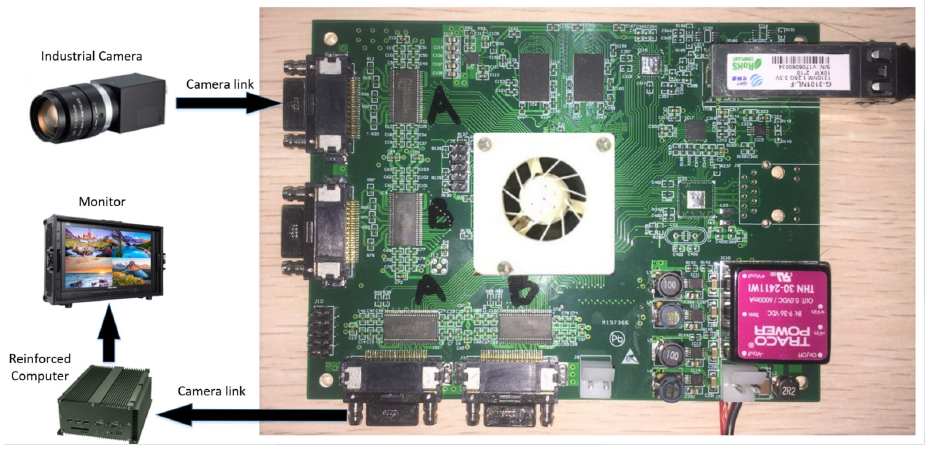
Figure 15. Video processing heterogeneous system